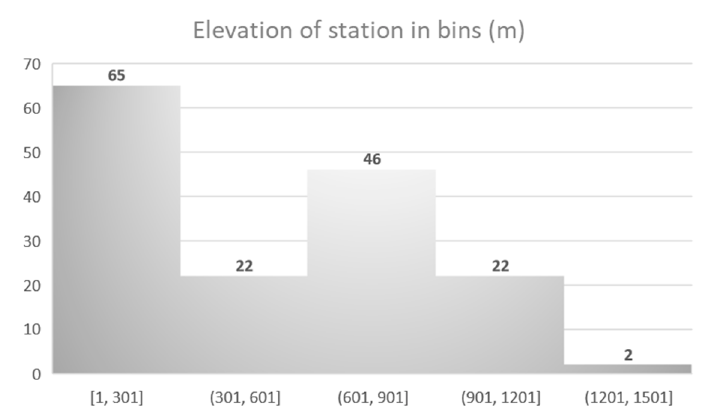
Figure 3. Histogram of stations elevation in meters.